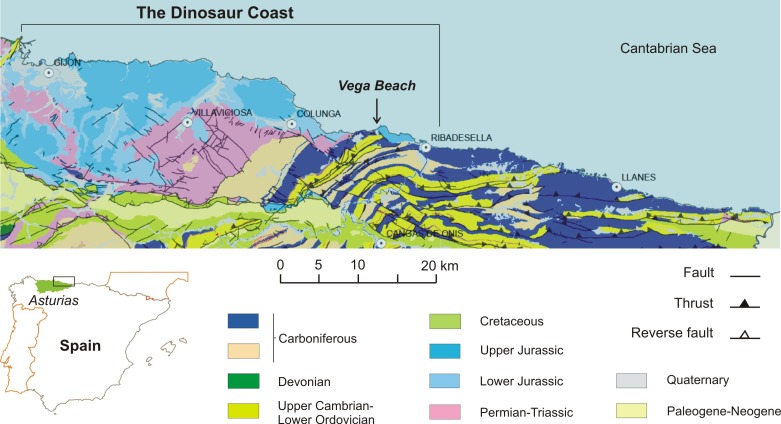
Geological map of the eastern Asturian sector, including the location of Vega beach (Ribadesella).Modified after Merino Tomé, Suárez Rodríguez & Alonso (2013).